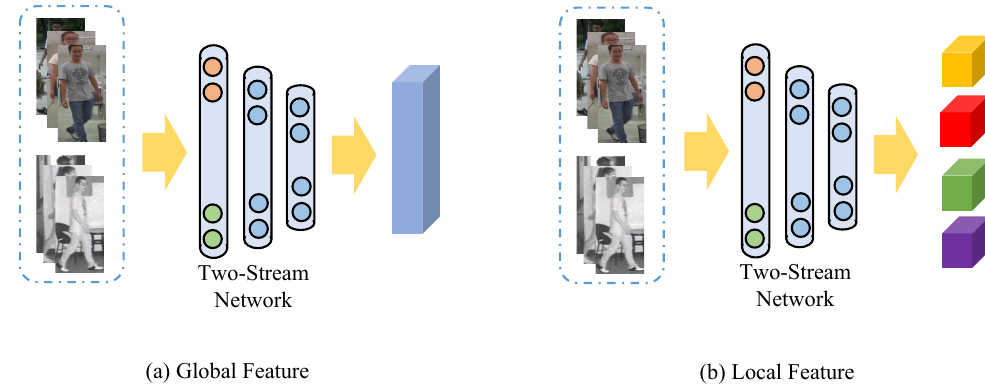
Figure 5. Two alternative ways for learning feature representations. ( a ) Global feature, learning modality specific and -shared feature representations. ( b ) Local feature, learning part-aggregated local